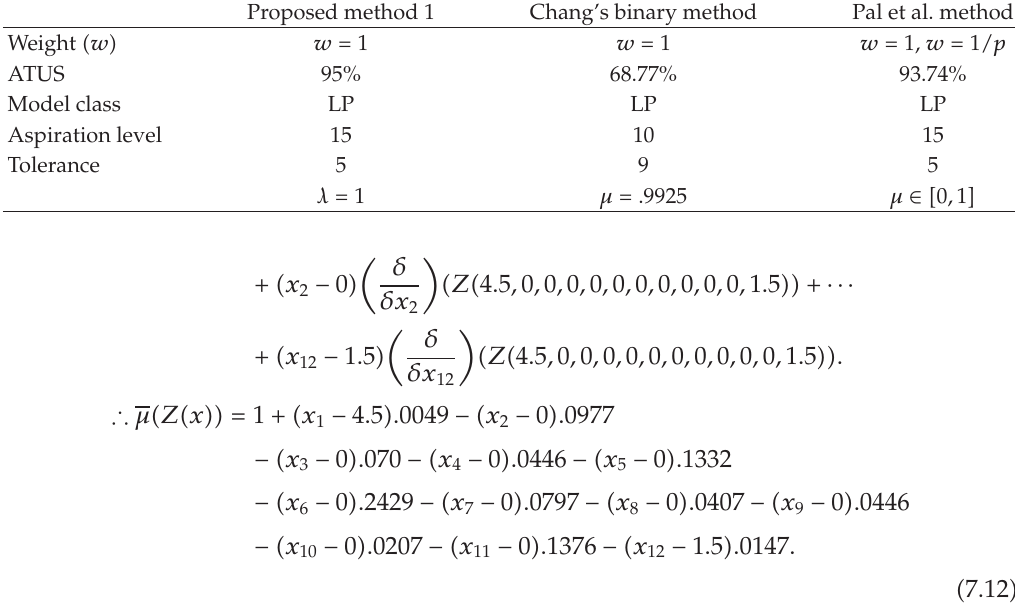
Journal of Applied Mathematics Table 7: Comparison. Proposed method 1 Chang’s binary